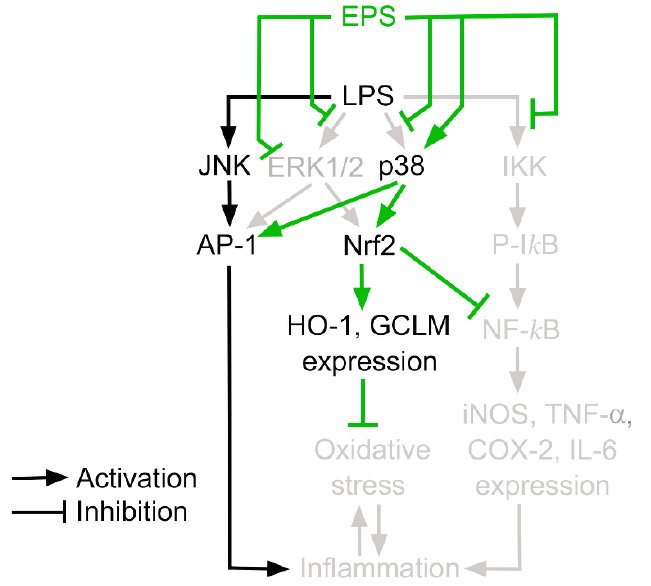
Figure 8. Schematic diagram displays the proposed mechanisms underlying the anti-inflammatory effect of EPS. The parts inhibited by EPS in the pathways are indicated by using light gray color.